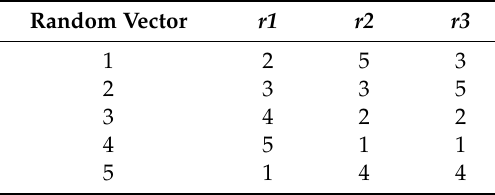
Table 5. Randomized vectors r 1 , r 2 , and r 3 .